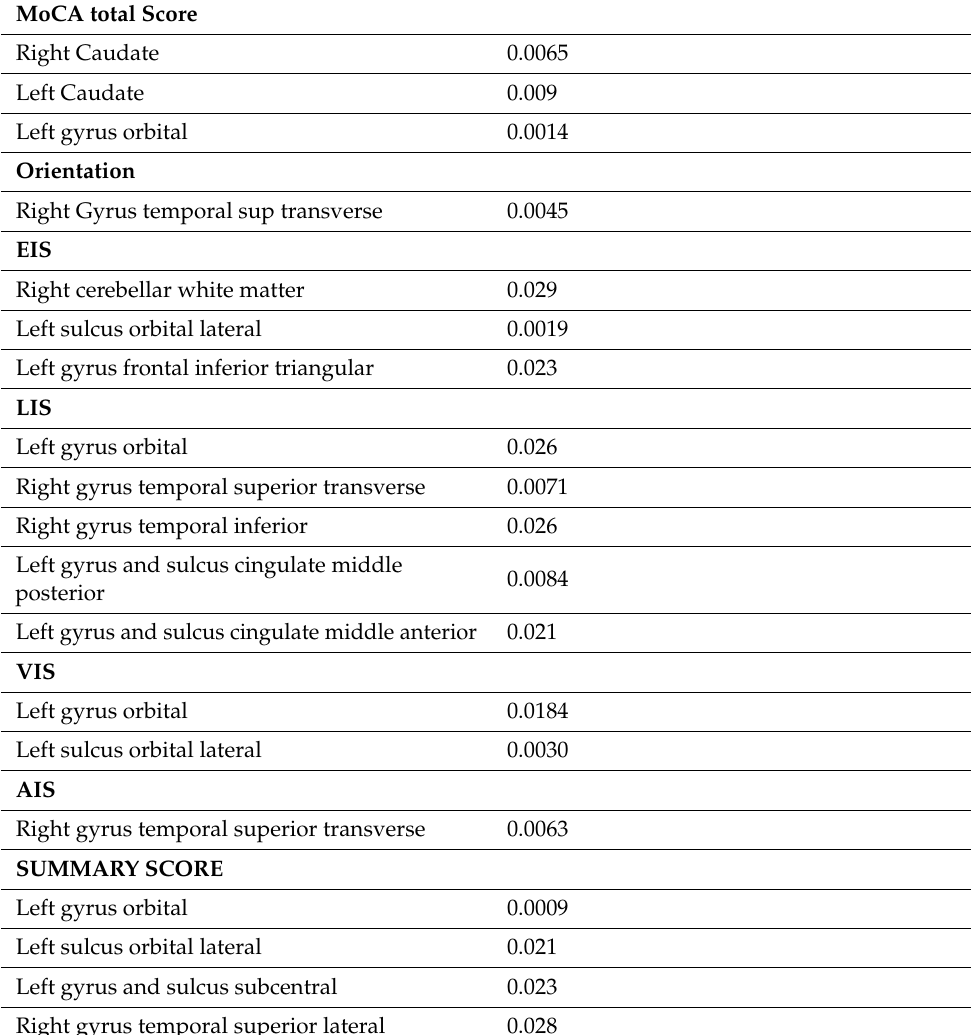
Table 3. The adjusted p values (adjusted for age and intracranial volume) for the significance of the linear association between MoCA Index scores and regional cerebral